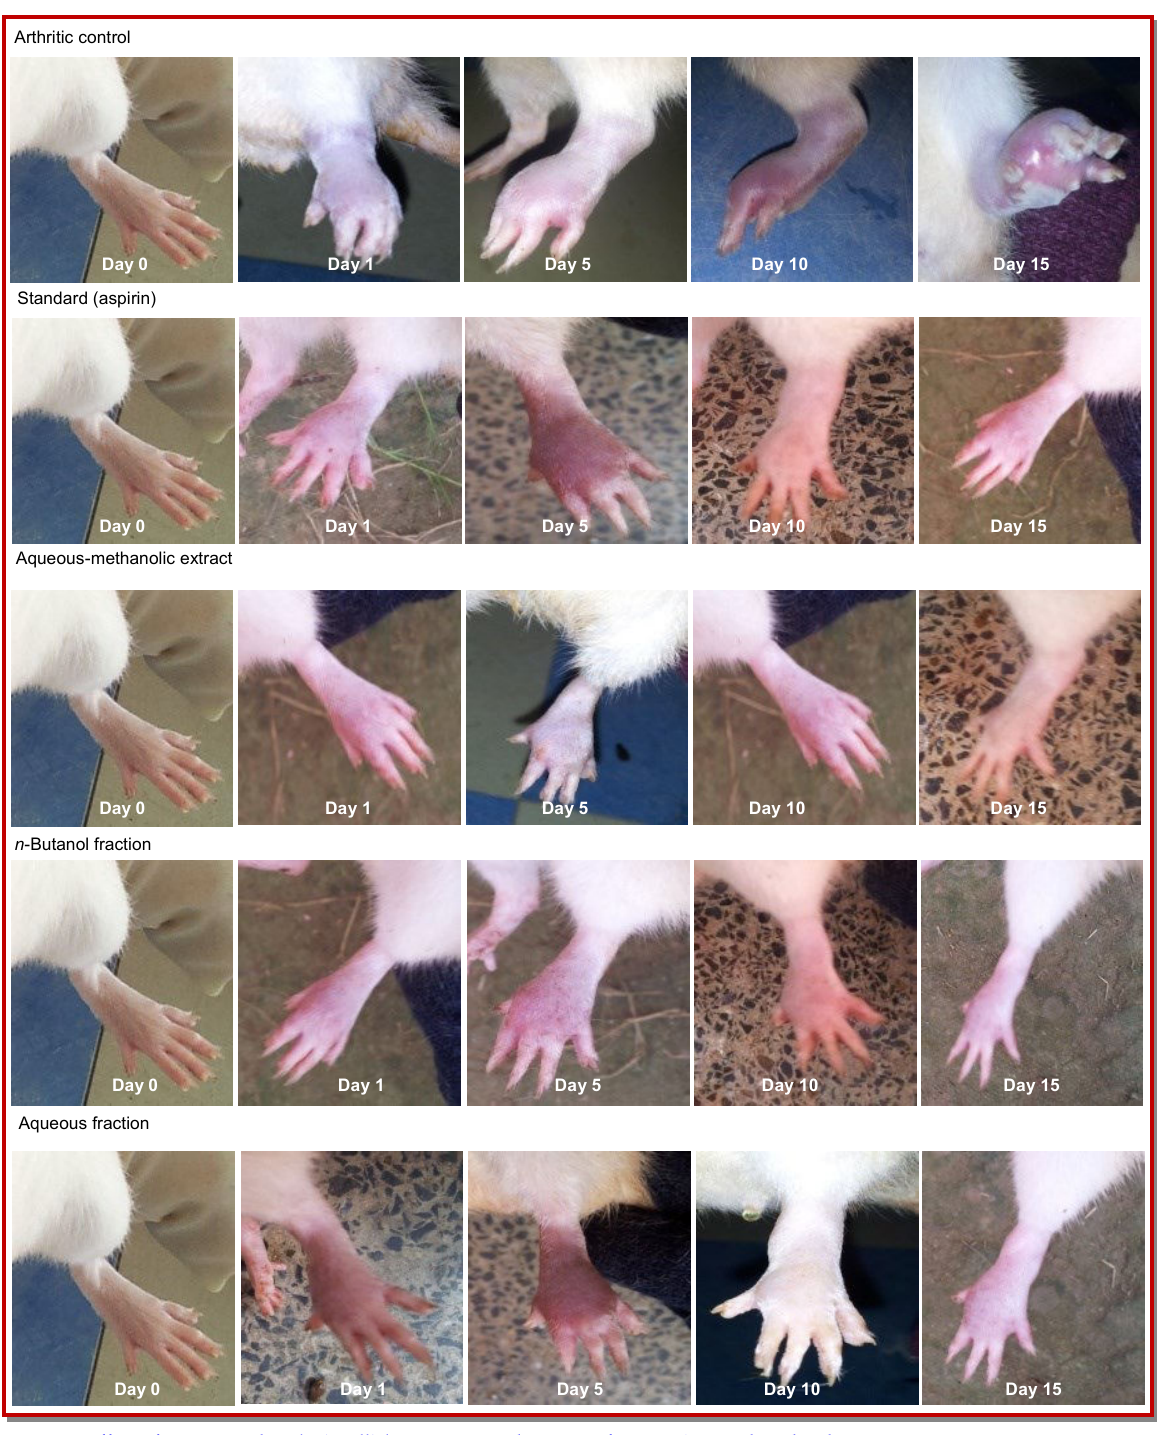
Figure 1: Effect of aspirin and Berberis calliobotrys on paw diameter of rats in CFA-induced